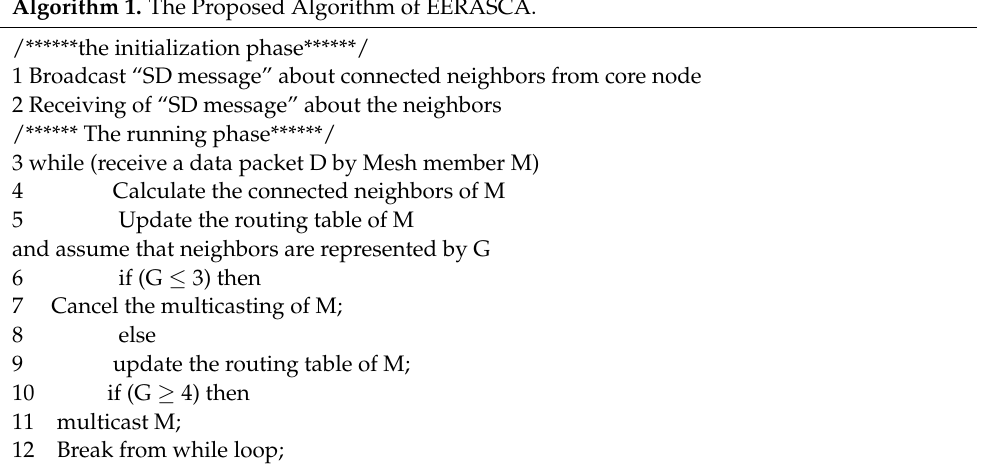
Algorithm 1. The Proposed Algorithm of